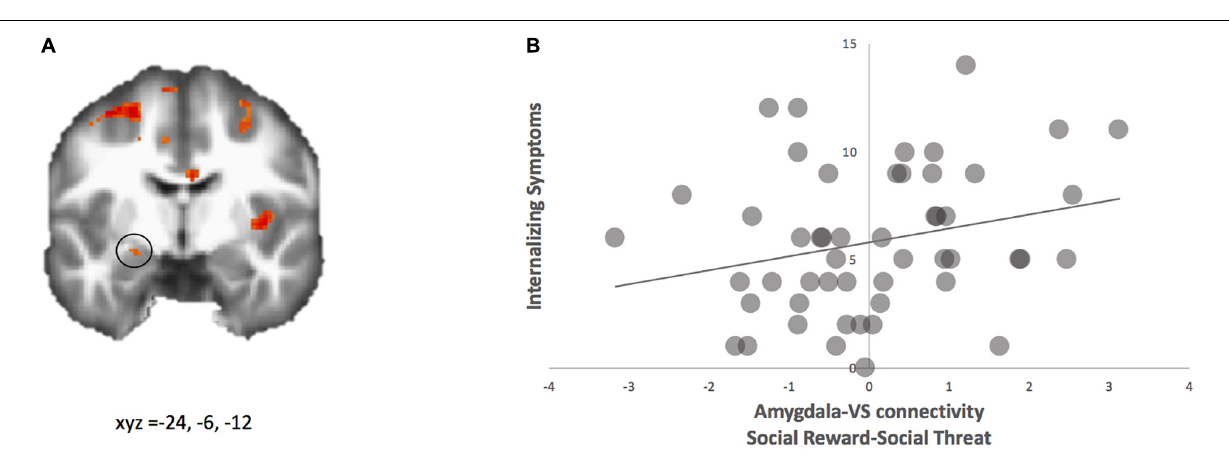
FIGURE 4 | PPI analysis with ventral striatum as seed. (A) Adolescents with higher internalizing symptoms showed greater functional connectivity between ventral striatum and amygdala (highlighted; MNI coordinates: x, y, z = –24, –6, –12) for social reward > social threat. (B) Parameter estimates of connectivity strength were extracted for descriptive purposes and plotted with internalizing symptom